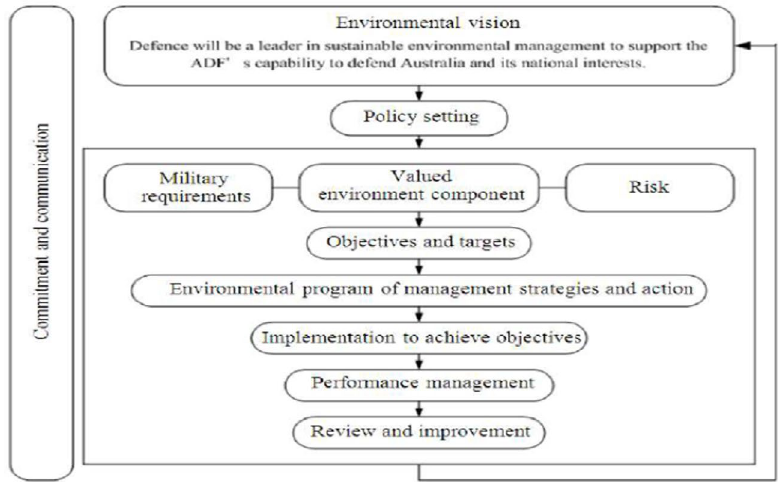
Fig. 1: The Australian Defence Force EMS model Fig. 1: TheAustralian Defence Force EMS model (Source: Wang and Wu, (Source: (Wang and Wu, 2013)